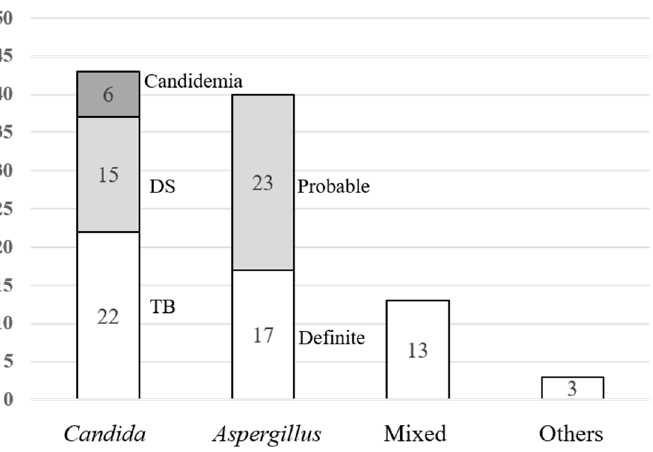
Figure 3. Classification of invasive fungal diseases. DS, disseminated fungal infection; TB, tracheo- bronchitis.